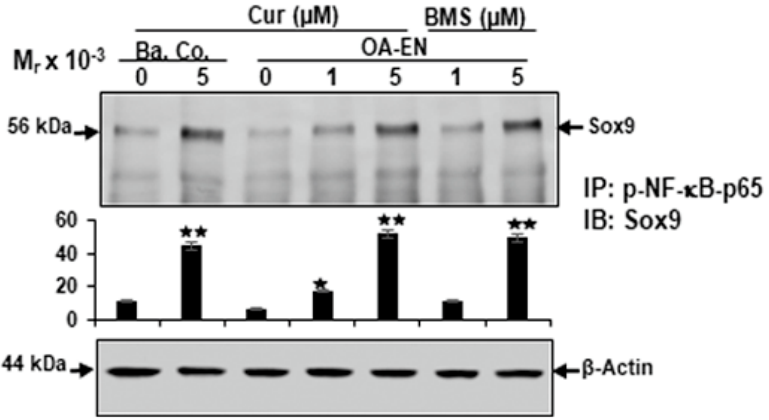
Figure 5. Influence of curcumin, BMS-345541 on the association of p-NF-kB-p65 to Sox9 in chondrocytes grown in OA-EN as shown by co-immunoprecipitation assay. Chondrocytes in alginate cultures by themselves (Ba. Co.) were kept untreated or treated with curcumin or co-cultured with fibroblasts and T-lymphocytes (OA-EN) and either kept untreated or treated with different dosages of curcumin (Cur) or with different dosages of BMS-345541 for 14 days, as outlined in Materials and Methods. Total cell proteins were immunoprecipitated (IP) with p-NF-kB-p65 and optimized by immunoblotting (IB) with anti-Sox9. The initial samples were run using an antibody to β -actin, which acts as a kind of control. Data were compared with the control, and statistically significant meaningful levels of p < 0.05 are marked with ( ★ ) and p < 0.01 with ( ★★ ).